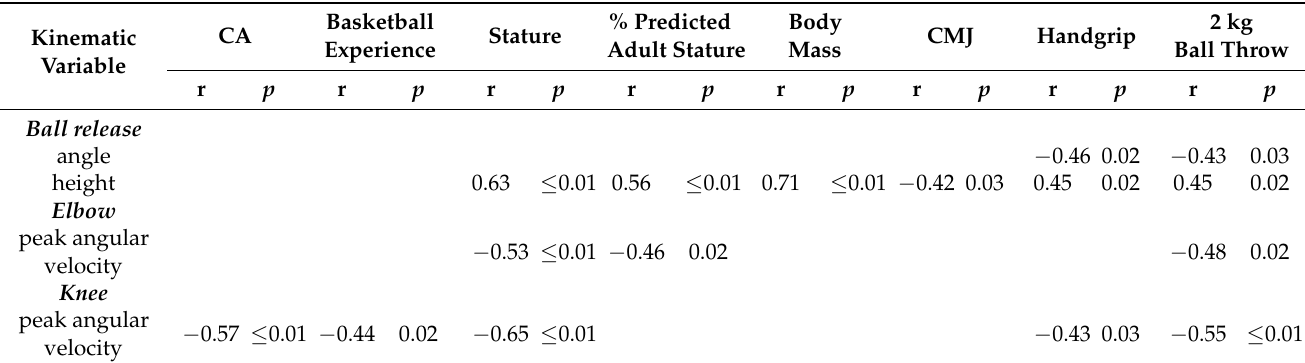
Table 4. Significant results according to Pearson-product coefficient correlations between selected kinematic parameters while performing with ball size 6, anthropometry, and fitness